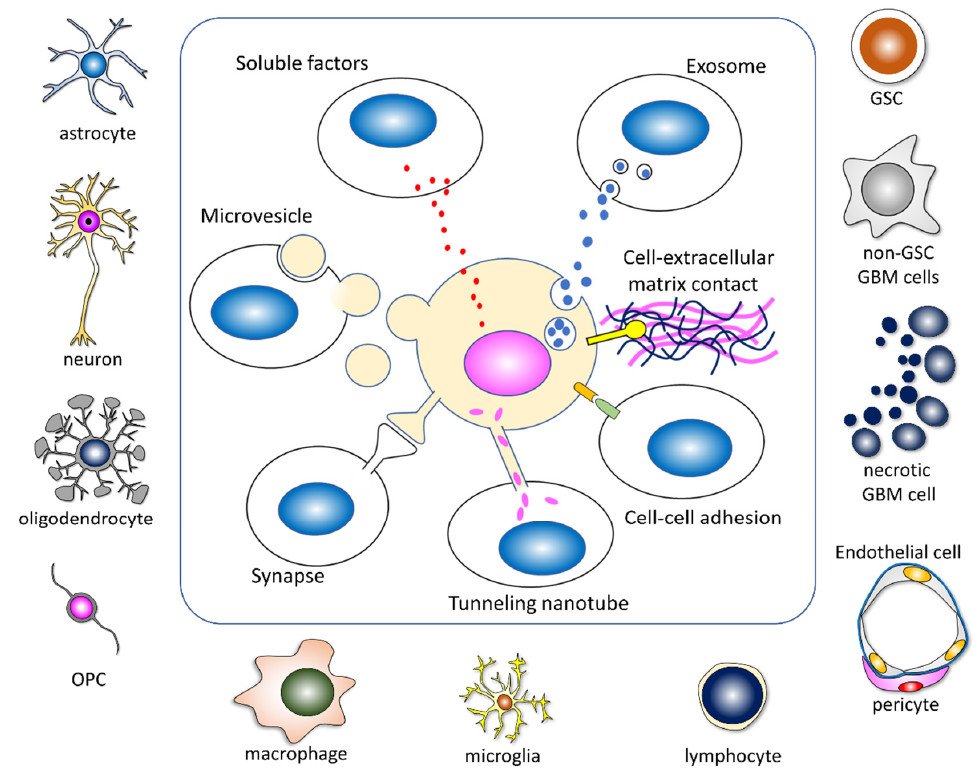
Figure 3. Multidimensional intercellular communication. GBM cells are affected by tumor microenvironments through direct contact and several interventions from GBM cells and non-GBM cells. Some extracellular vesicles contain informative molecules containing proteins, RNAs, DNAs, and surface receptors.